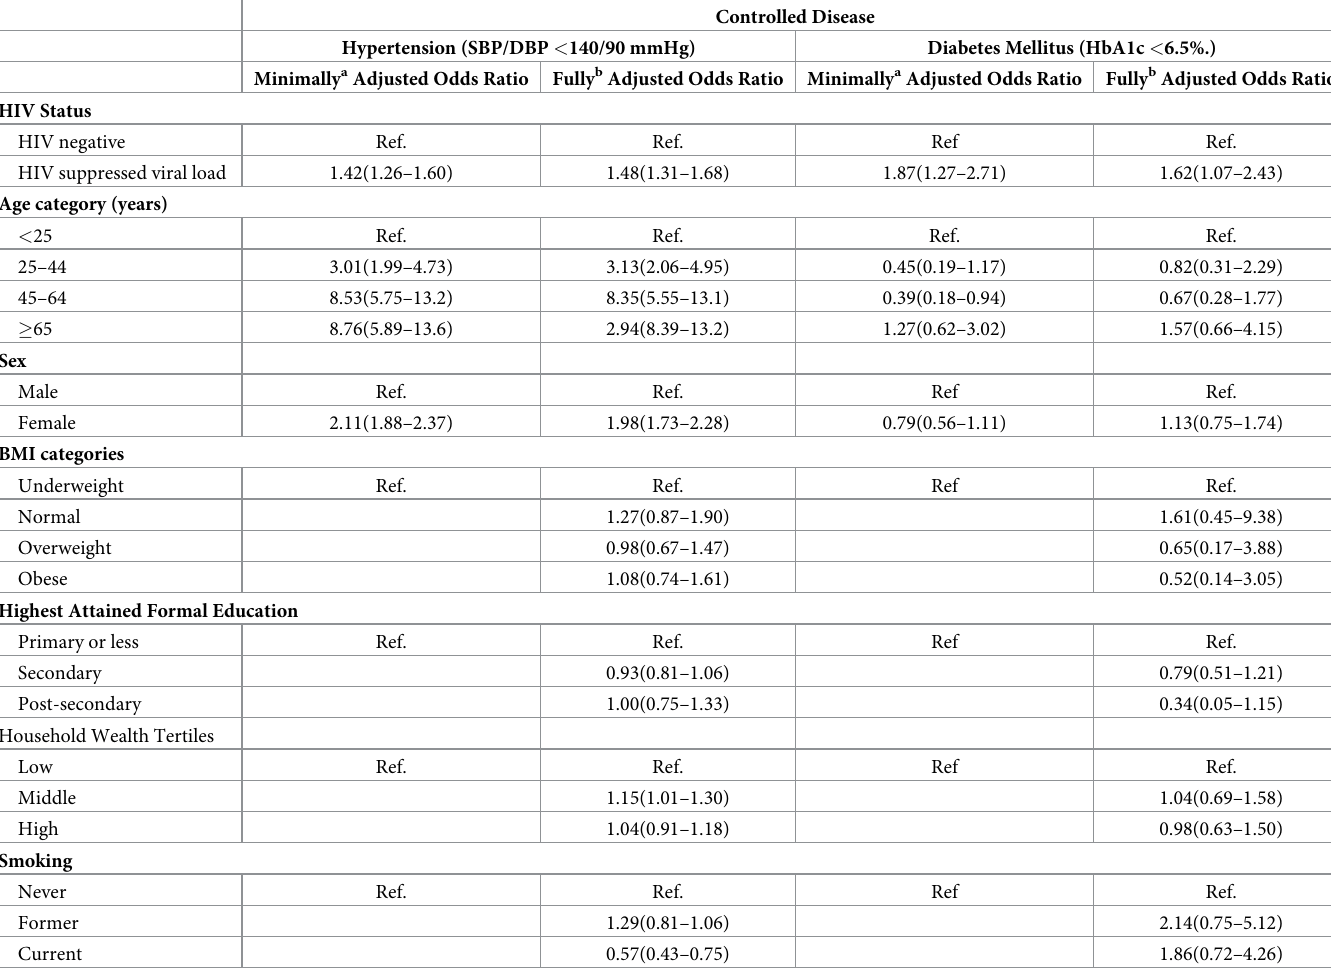
Table 3. Determinants of hypertension and diabetes mellitus control among adults in in uMkhanyakude, KwaZulu-Natal, South